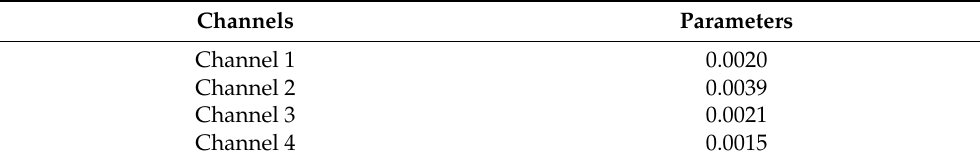
Figure 13. Delay parameter. Table 11 is the number of delay on each channel. Table 11 is the number of delay on each channel. Table 11. Delay parameter. Table 11. Delay parameter.